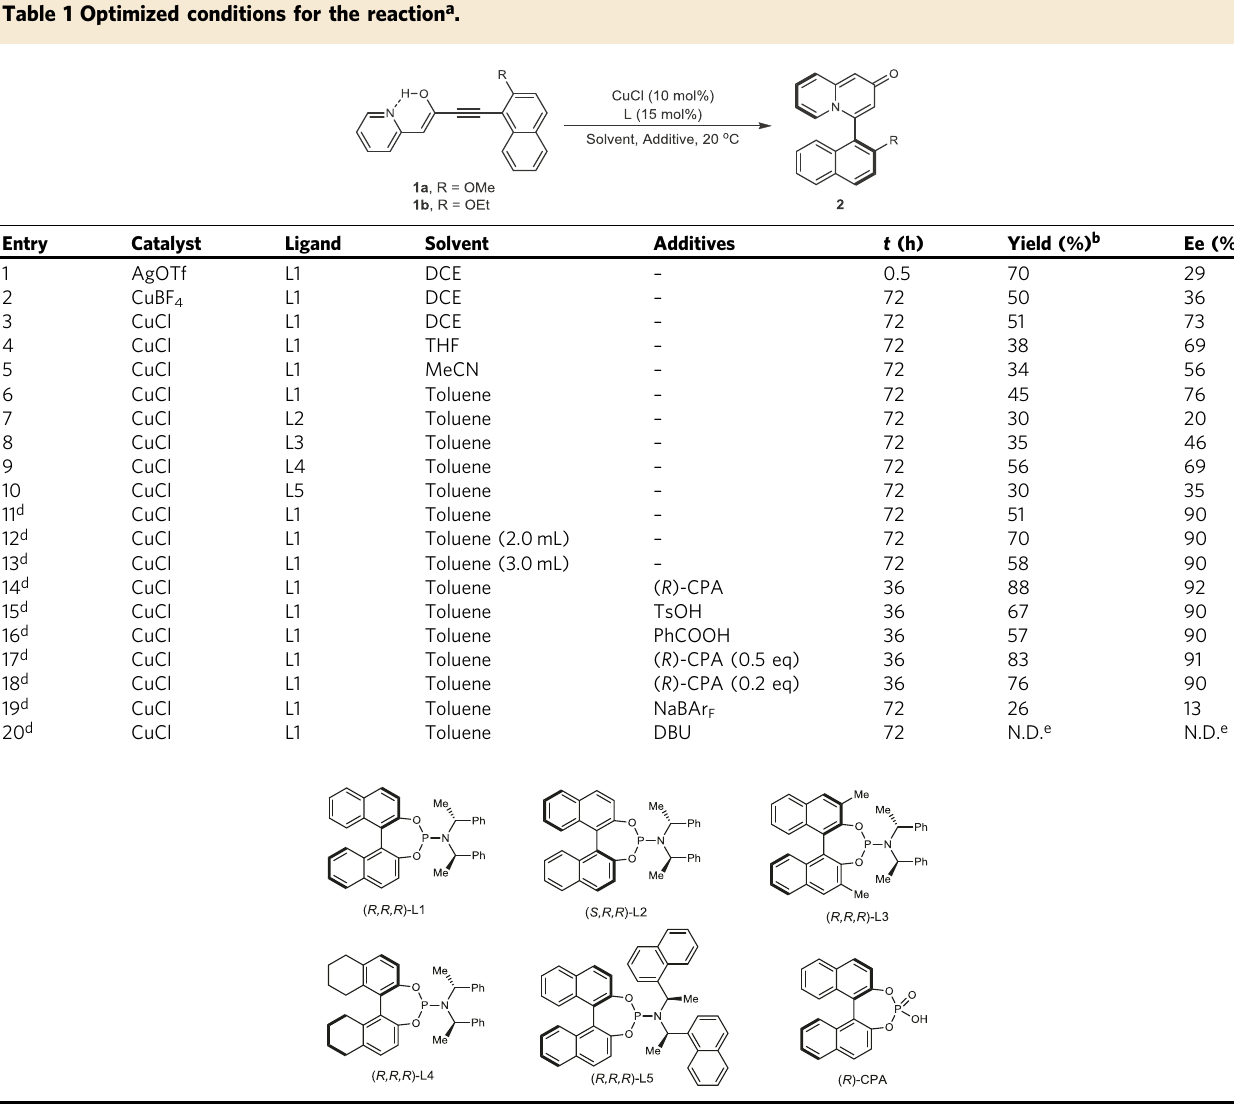
Table 1 Optimized conditions for the reaction a